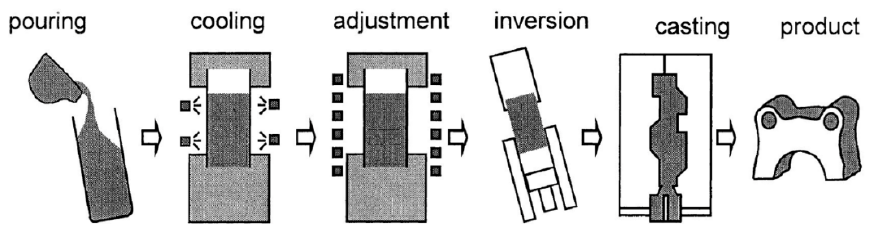
Figure 2. Schematic illustration of the stages of new rheocasting (NRC) process. Reprinted with permission from Ref. [23]. Copyright 2001 John Wiley and